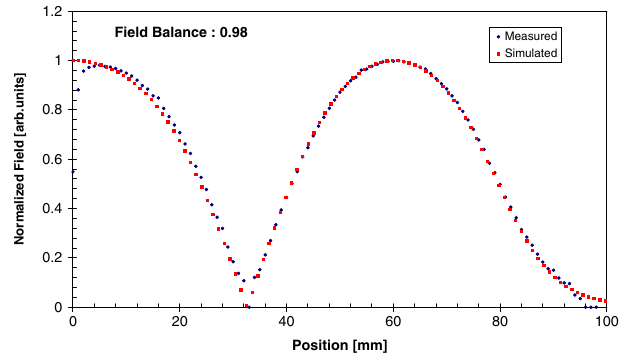
FIG. 6. Measured and simulated field balance for the new gun, after final tuning. The measurements were taken by the bead pull method using a vector network analyzer. The field pattern was measured after each cut on the cavity surface.